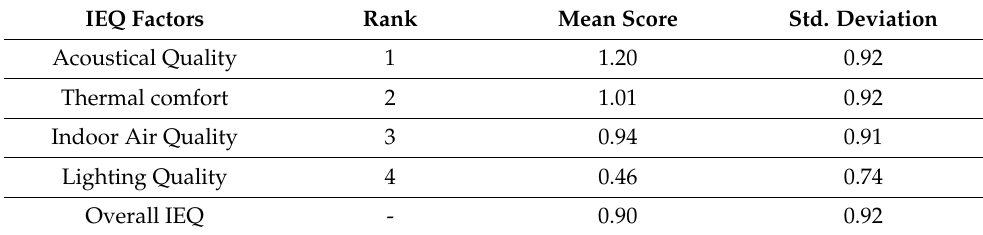
Table 6. Occupants’ satisfaction mean score and standard deviation of factors and overall